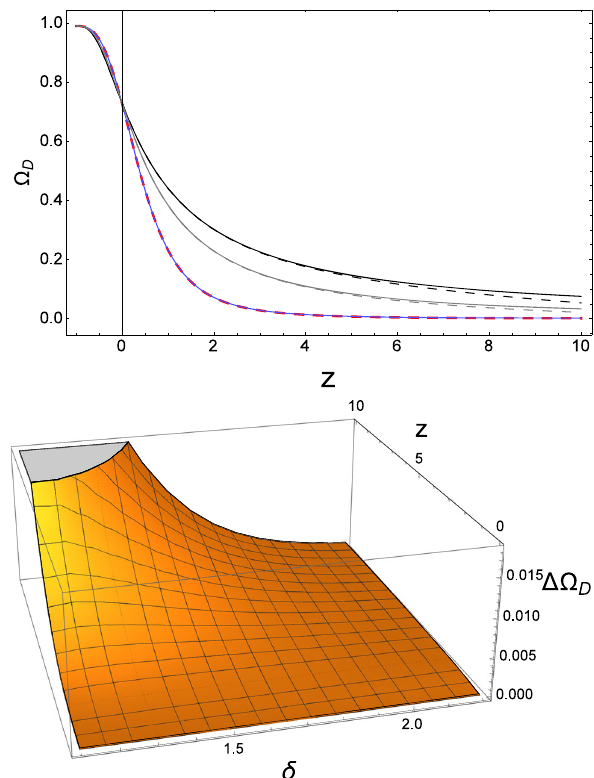
Fig. 9 Upper panel: The evolution of (cid:5) D versus redshift parameter = 0 . 73, (cid:5) = 2 . 47 × 10 − 5 , b 2 = 0 . 03 and b 2 = 0 . 01. z for (cid:5) 0 r 0 D 1 2 The dashed (solid) black and gray curves represent evolution of (cid:5) D for δ = 1 . 4 and δ = 1 . 55, respectively, when radiation fluid is present (absent) and the dashed red (solid light blue) curve represents evolution of (cid:5) D for δ = 2 . 2 whenradiationfluidispresent (absent). Lowerpanel: Evolution of the difference between THDE density parameters with and without considering radiation as a function of redshift and δ parameter